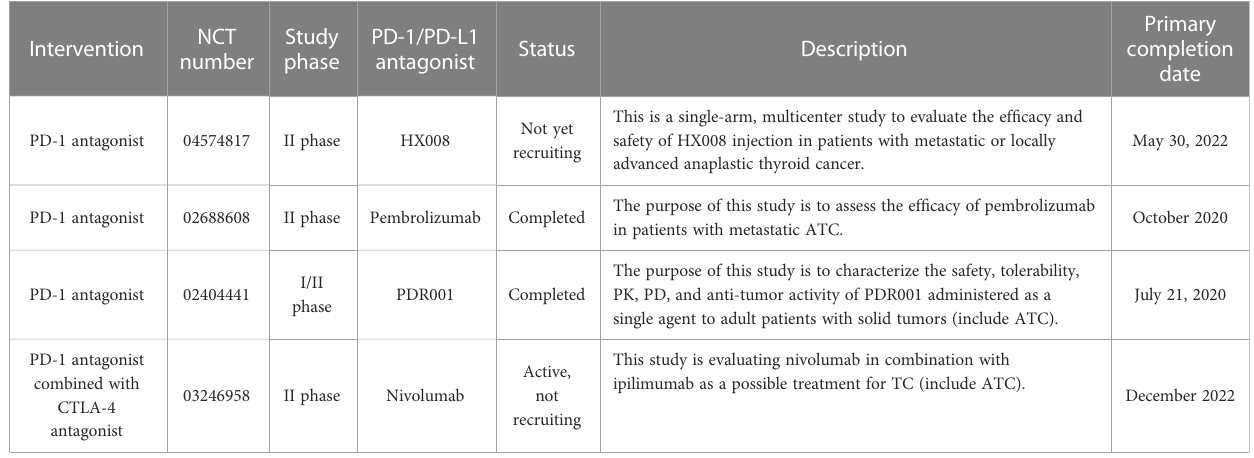
TABLE 2 Clinical trials of immunotherapy for